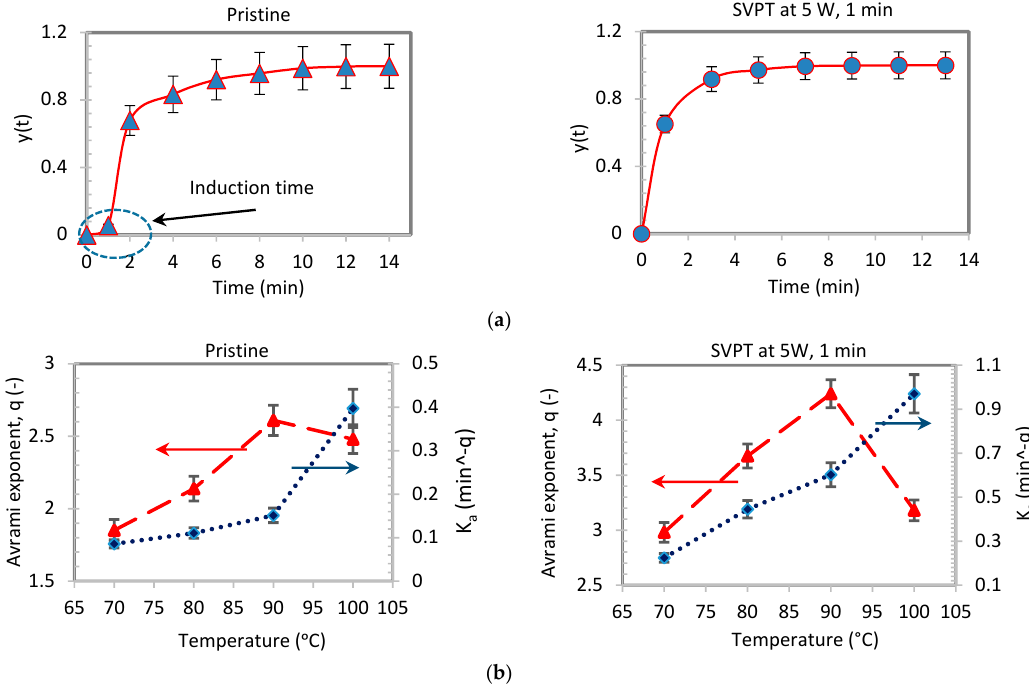
Figure 5. ( a ) Crystallized fraction, y ( t ), versus time, t , measured by TG at 90 °C. ( b ) Avrami exponent and the rate constant versus temperature, for pristine and the SVPT thin films (5 W and 1 min). The values of the reaction rates ( K a ) calculated from the TG measurements were plotted versus 1/RT in the log-log axes based of the Arrhenius equation, as follows: